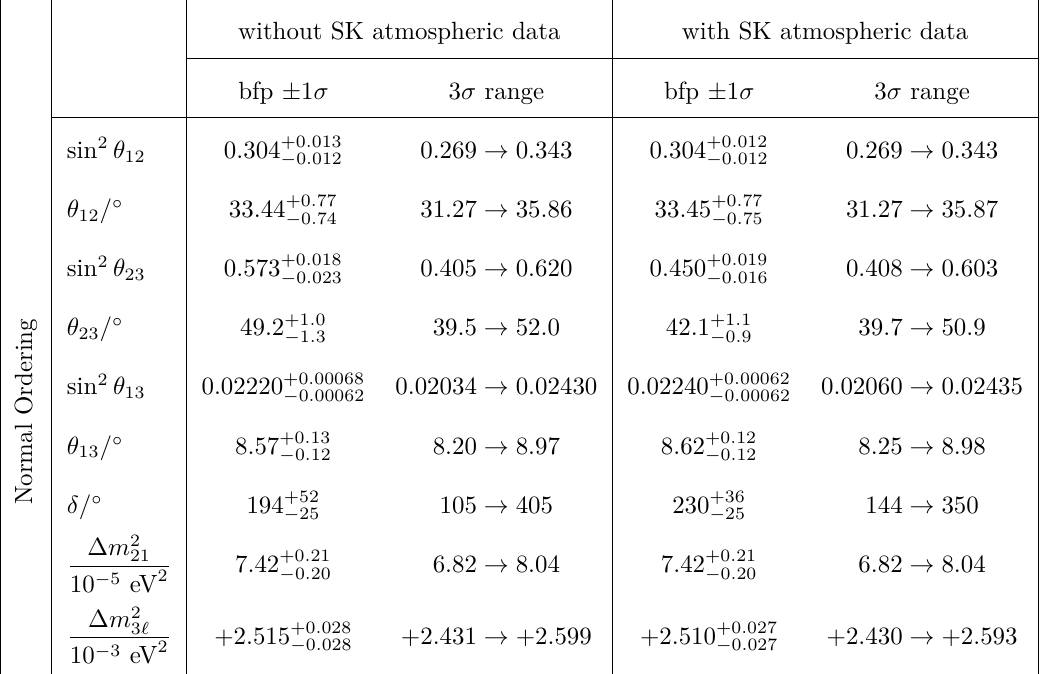
Table 3 . Normal Ordering NuFit 5.1 values [42, 43] for the neutrino